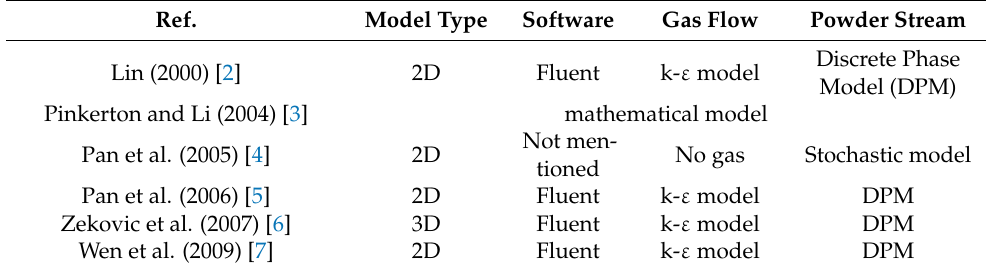
Table 1. The chronological development of models on powder stream simulation for coaxial nozzle.